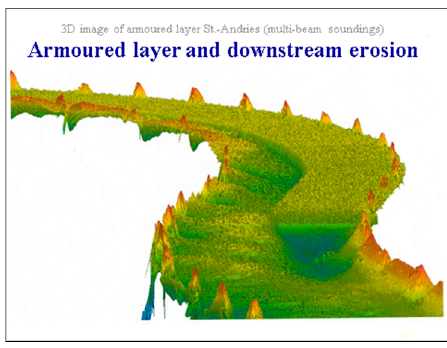
Figure 14. Morphological effects of fixed layer at the St. Andries bend (copyright Kees Nuijten).